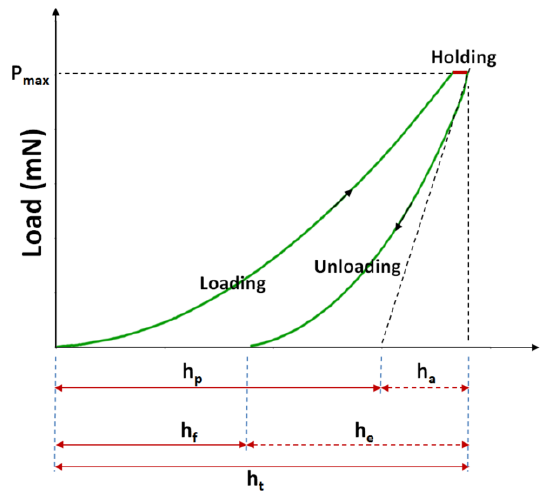
Figure 9. Representative plot of load versus displacement.